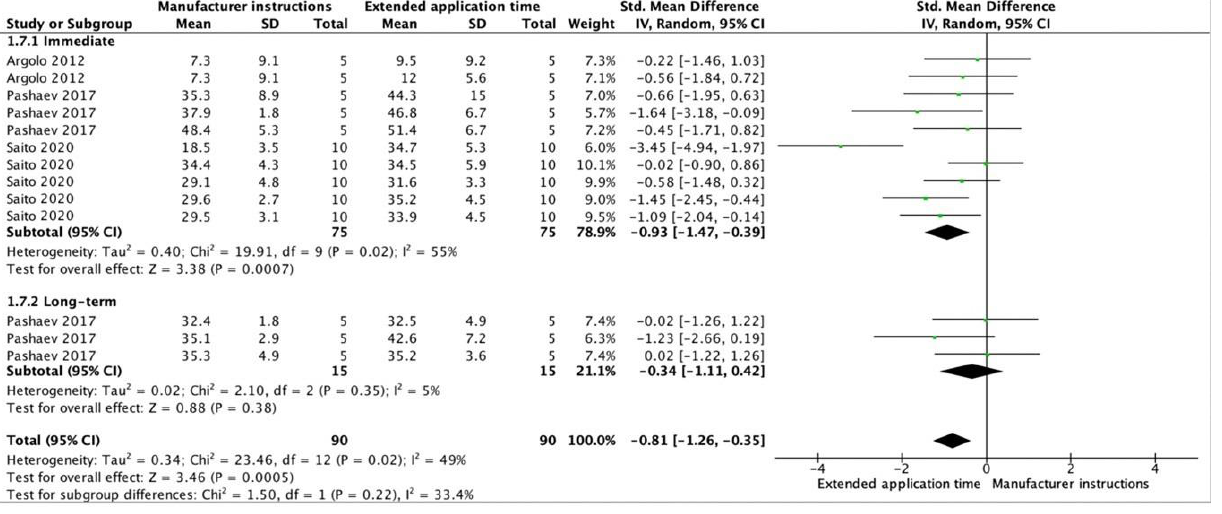
Figure 3. Forest plot showing the bond strength values when the adhesive was applied by extending their application time